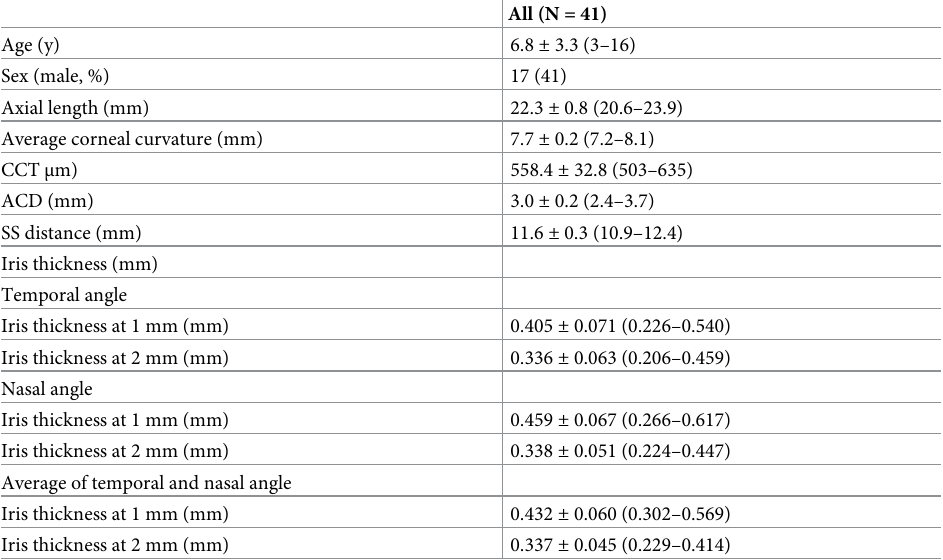
Table 1. Patient